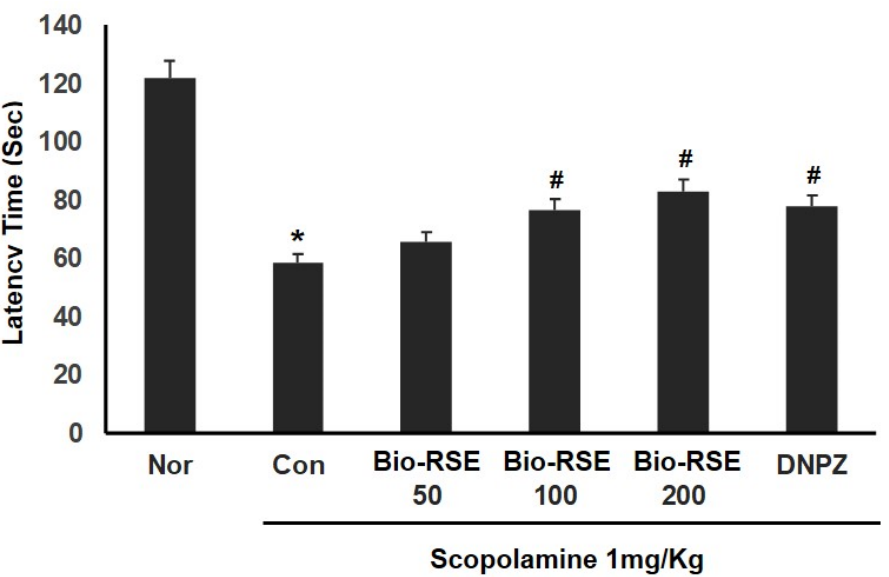
Figure 4. Effect of Bio ‐ RSE on step ‐ through latency in the passive avoidance test. Values are the mean ± SD. Normal—oral administration of drinking water + 0.9% NaCl i.p.; control—oral admin ‐ istration of drinking water + scopolamine 1 mg/kg i.p.; Bio ‐ RSE 50—oral administration of Bio ‐ RSE